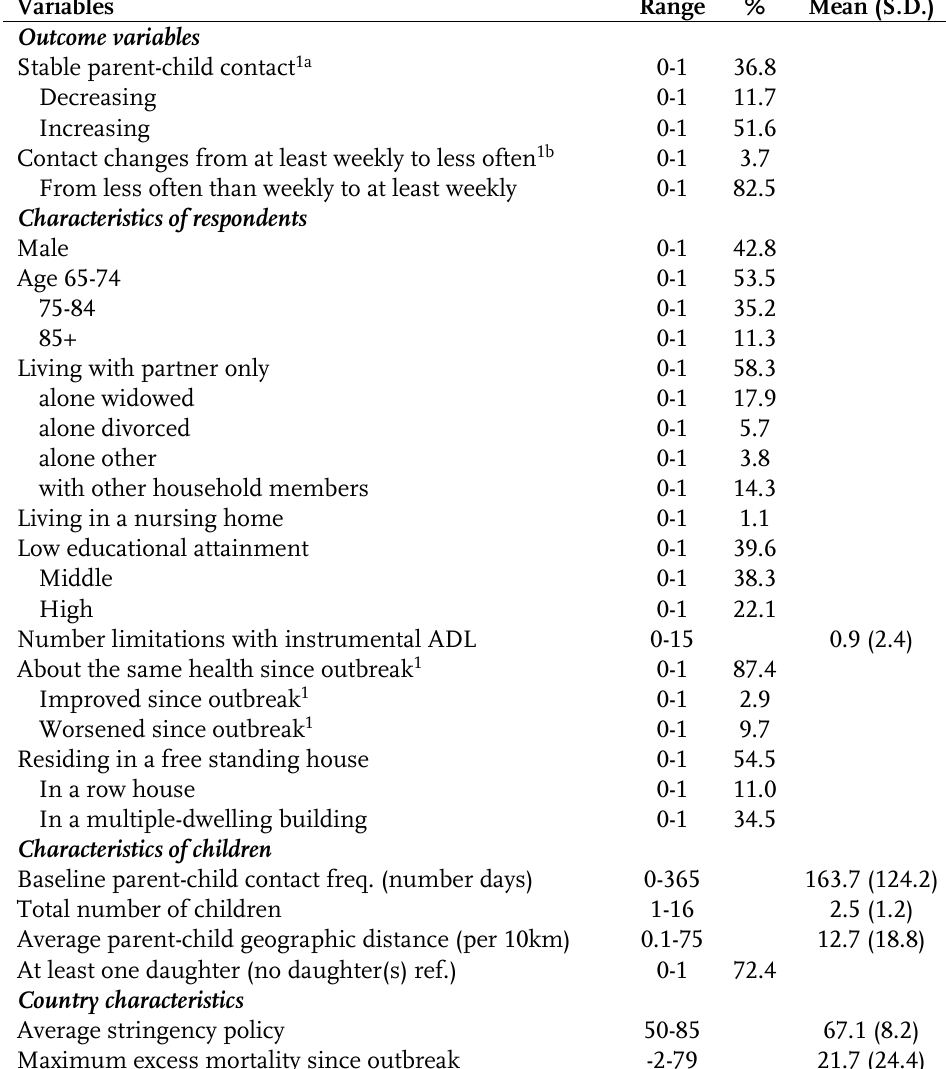
Table 1 : Descriptive statistics of variables for selected sample of parents (aged 65 or older) with at least 1 non-coresident